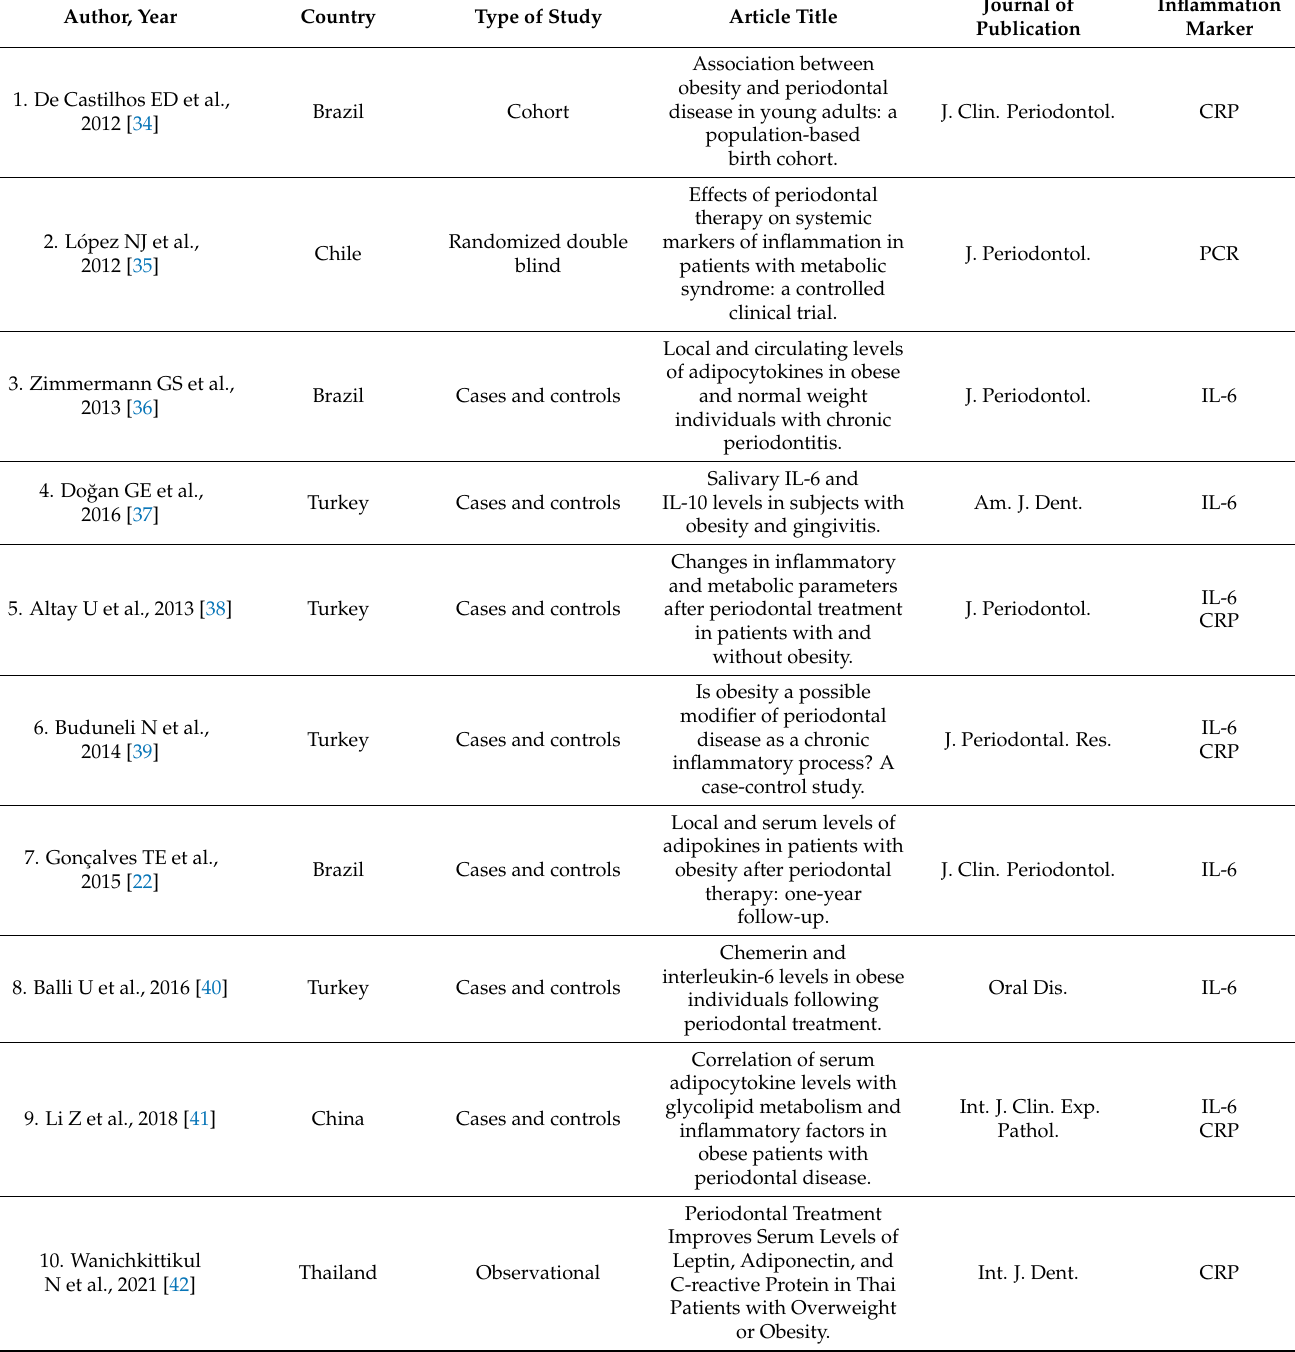
Table 2. General Summary of the Selected